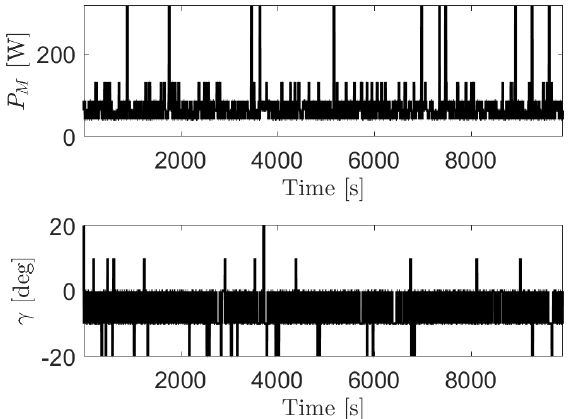
Figure 7. sUAV P M and γ versus time, Simulation Scenario